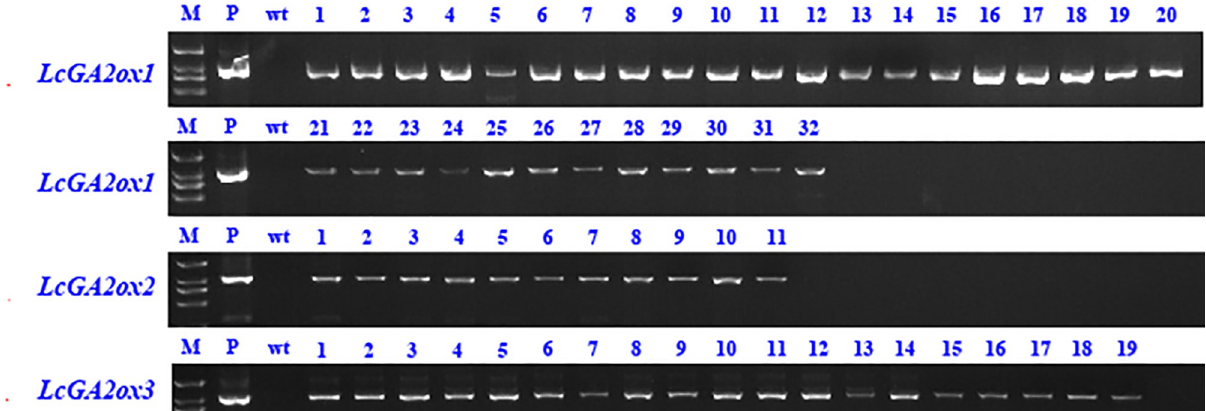
Fig 7. PCR analysis of 35S :: LcGA2ox1 transgenic tobacco plants. M, Marker DL2000. P, positive control. wt, wild type.